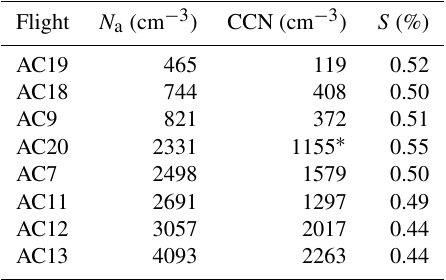
Table 2. N a and CCN at cloud base for each flight considered in this study. ∗ CCN concentrations for flight AC20 showed pronounced scaling with S . The value shown is for the measurements in which S> 0 . 52%. This value is closer to the maximum droplet concentra- tion measured at the base of the clouds ( = 1422cm − 3 )